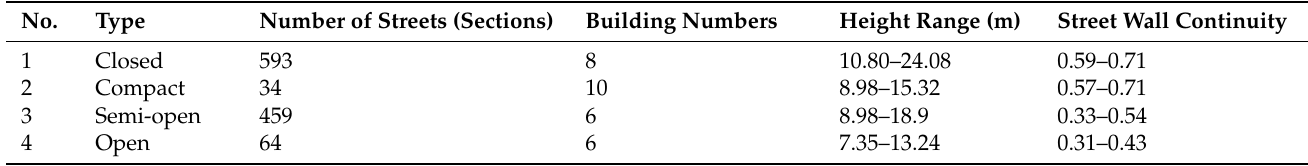
Table 5. Classification of street space in downtown